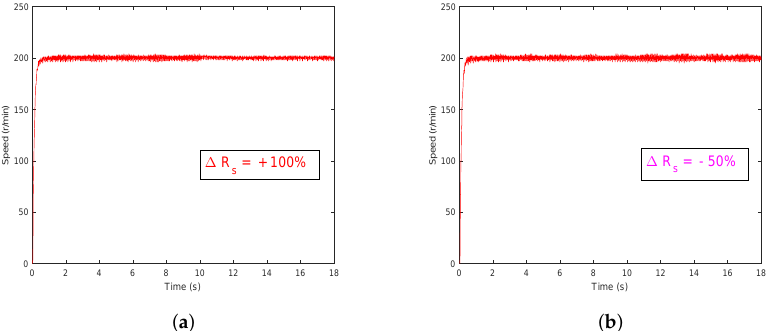
Figure 15. Speed response curves under GPC+ESO method with a sudden change of stator resistance value. ( a ) ∆ R s = + 100%; ( b ) ∆ R s = − 50%.